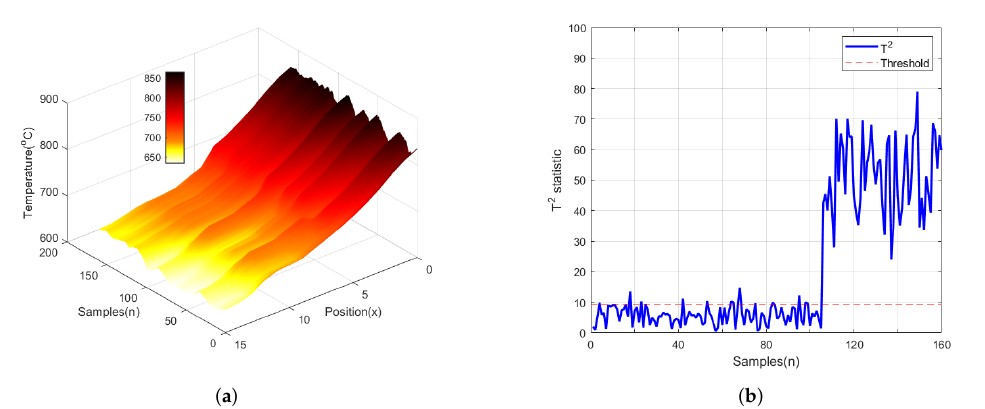
Figure 12. The temperature distribution ( a ) and monitoring result ( b ) of fault one.